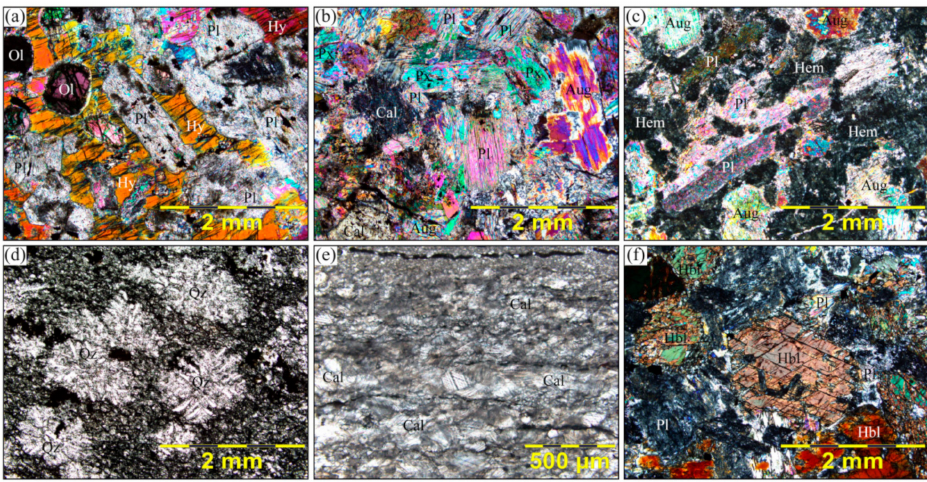
Figure 11. Photomicrographs under orthogonal polarization of typical samples collected from Huangshan intrusions ( a ): X1; ( b ): X2; ( c ): X3; ( d ): X4; ( e ): S1; ( f ): D2. Location of the samples is shown in Figure 4d. Aug: augite; Cal: calcite; Hbl: hornblende; Hem: hematite; Hy: hypersthene; Ol: olivine; Pl: